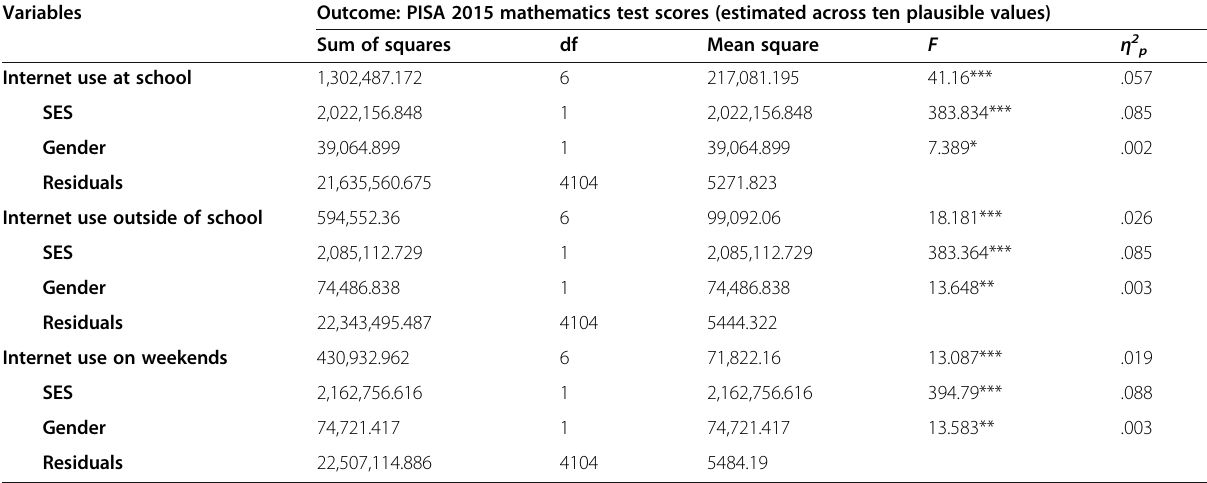
Table 2 Results of ANCOVA analyses for PISA 2015 mathematics test scores (estimated across ten plausible values) and Internet use variables, controlled for SES and gender